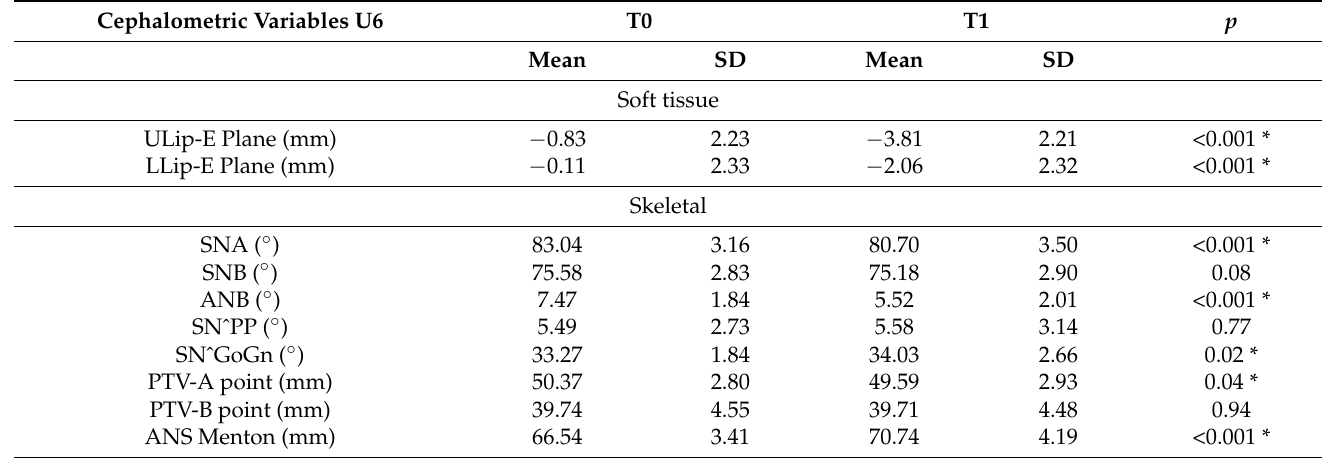
Table 3. Cephalometric variables at T0 and T1 (means and SD) for the U6 group and results of the paired sample t -test ( p -values); * p <